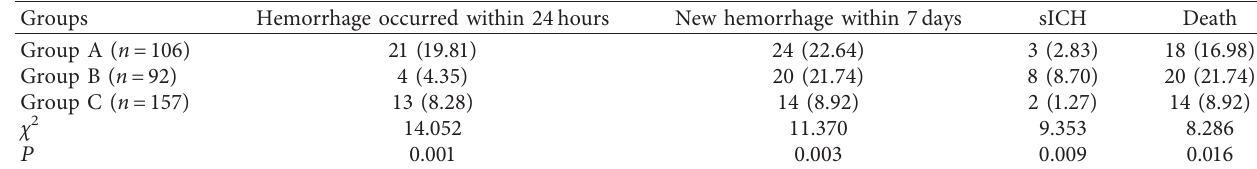
Table 2: Comparison of complications and deaths among the three groups.